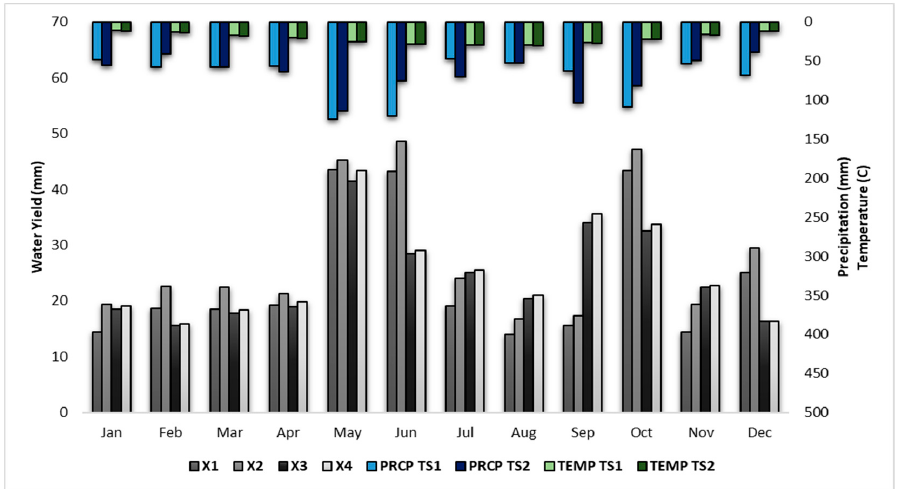
Figure 13. Monthly water yield change for the Walzem Creek watershed under different scenarios. Water 2020 , 12 , x FOR PEER REVIEW